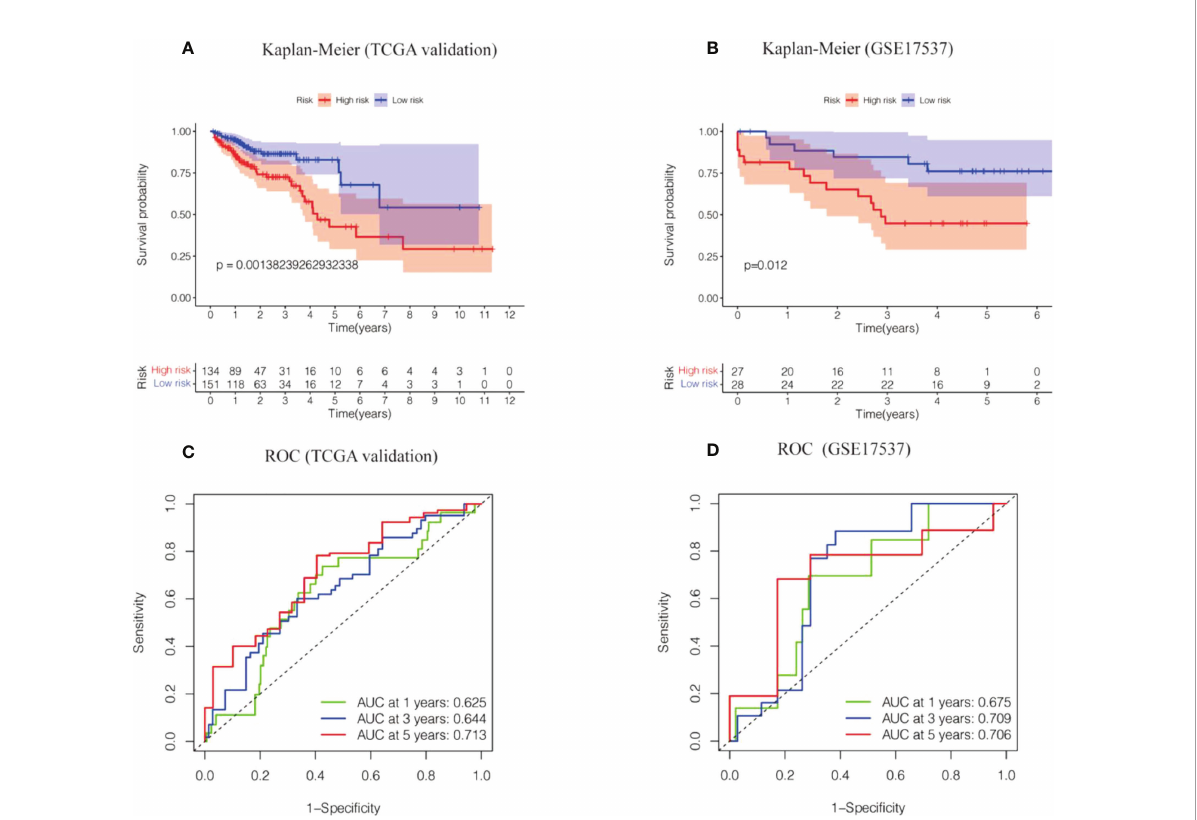
FIGURE 4 The risk model of the 6 cell senescence-related lncRNAs in the TCGA validation cohort and GSE17537. (A) Kaplan-Meier analysis of the OS for high and low risk groups in the TCGA validation cohort. (B) Kaplan-Meier analysis of the OS for high and low risk groups in GSE17537. (C) Time-dependent ROC curve depicting the predictive accuracy of the risk model in the TCGA validation cohort. (D) Time-dependent ROC curve depicting the predictive accuracy of the risk model in